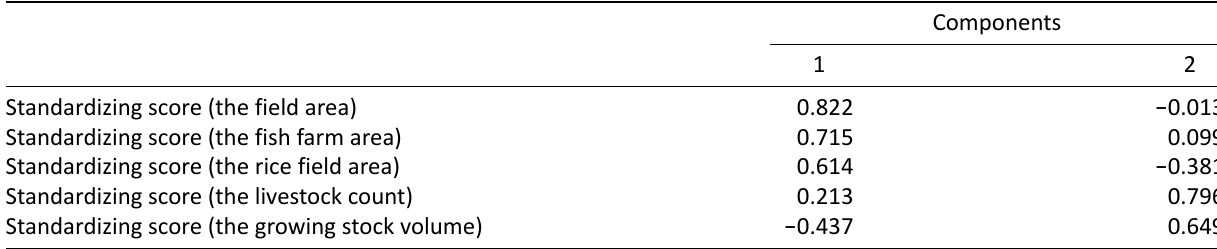
Table 4. Result of the rotated component matrix for the characteristic variables of the primary rural industry.